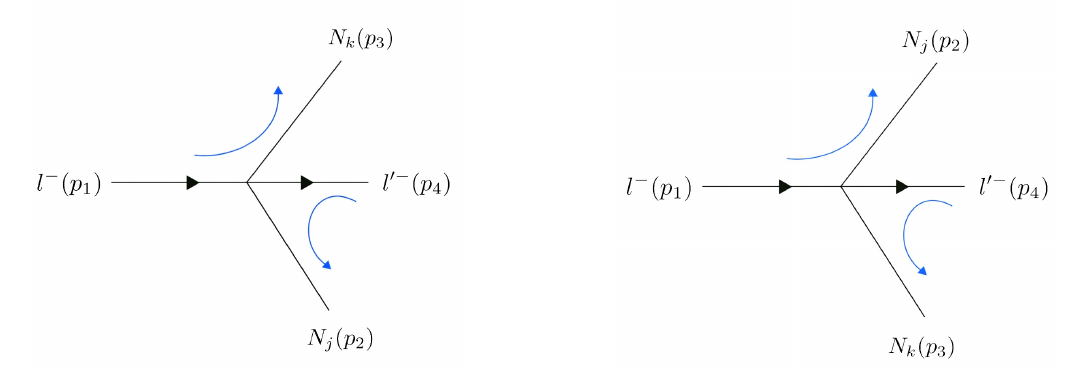
Figure 1. Feynman diagrams for the ‘ − −→ ‘ 0− N j N k decay. The orientation chosen for the fermion chains is defined by the blue